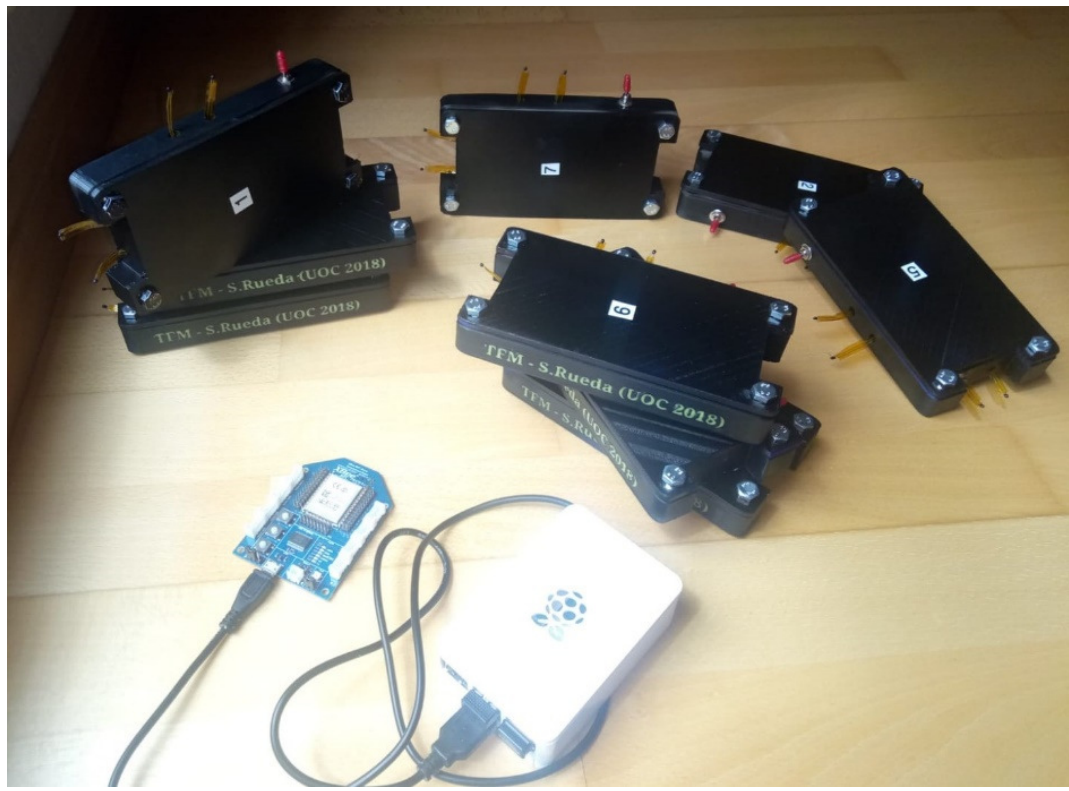
Figure 12. The upper part shows all nine nodes, bottom-left part the collector node, and the bottom-right case is the raspberry pi